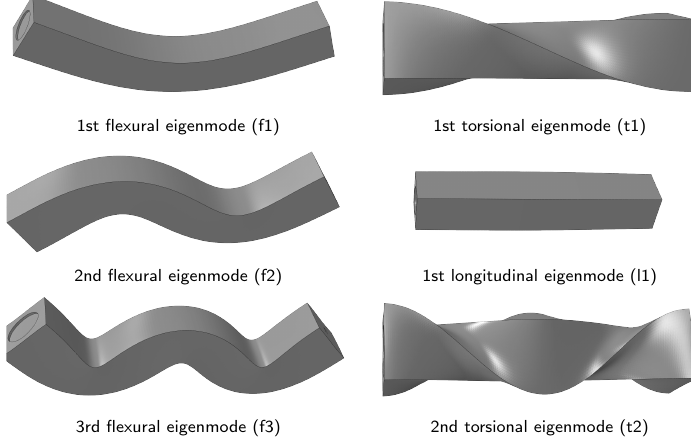
Figure 4. Eigenmodes 1–6 of the specimen obtained by FEM